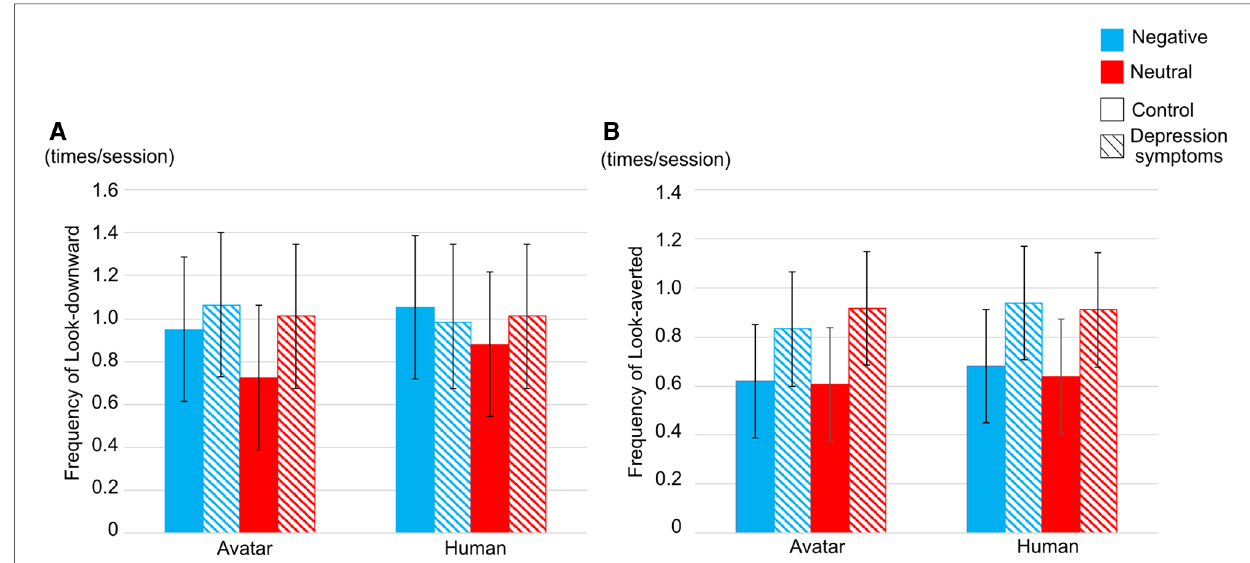
FIGURE 4 Frequency of ( A ) look-downward and ( B ) look-averted in each interviewer. Striped pattern boxes indicate the data of the depressed symptoms group, and solid boxes are the control group. Error bars indicate 95% CI.